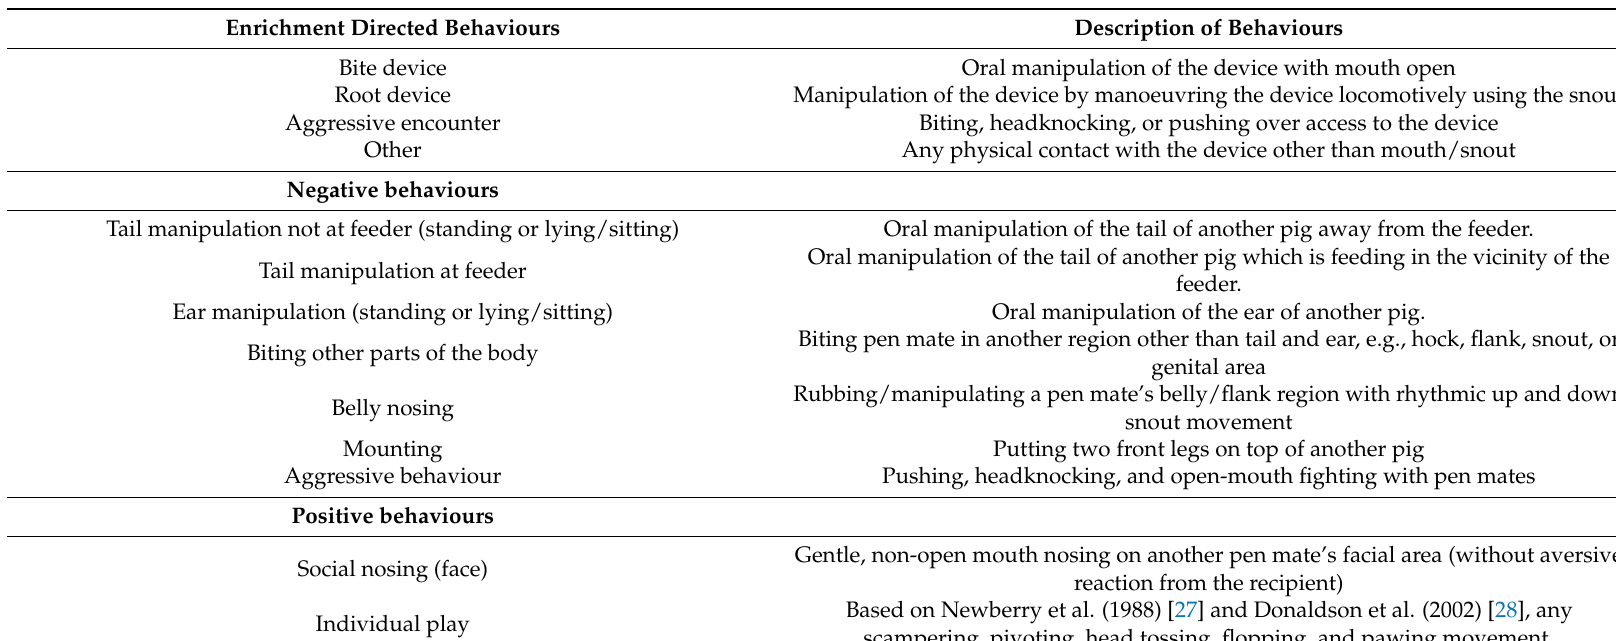
Table 3. The ethogram used for behaviour